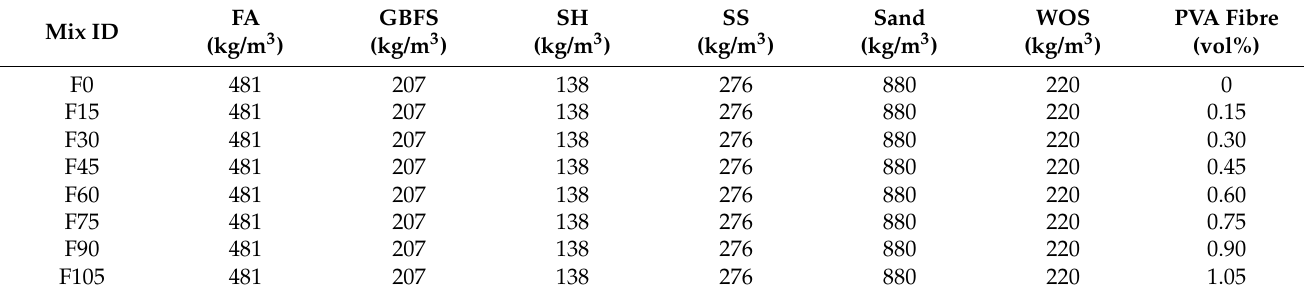
Table 3. Mix Proportions of F15–F105.